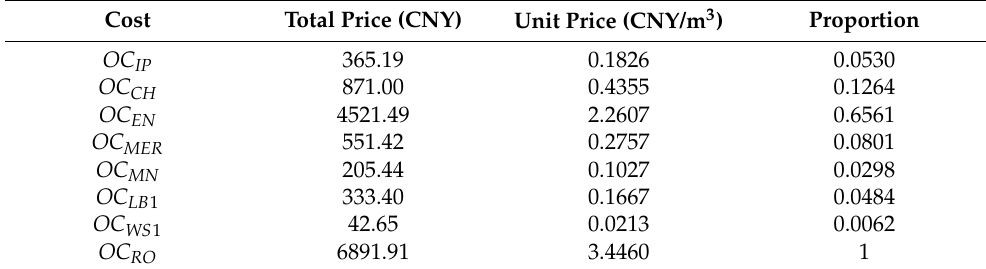
Table 11. SWRO system cost ratio table.